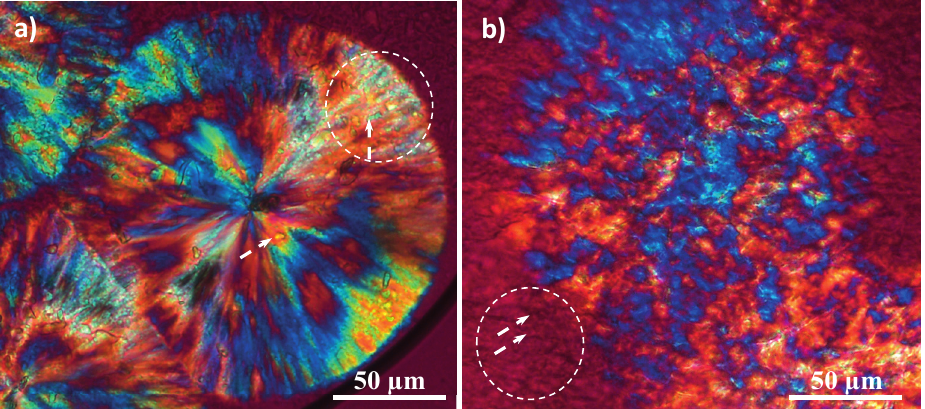
Figure 12. Polarizing optical micrographs showing spherulitic morphologies of the - b -PPhe sample obtained during isothermal crystallization at representative PLLA 25 13 132 °C ( a ) and 135 °C ( b ). Circles point out domains where aggregates (white arrows) could be well